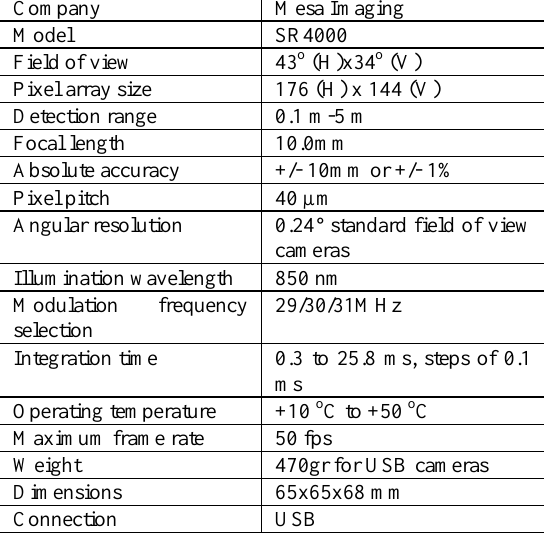
Figure 2. The measurement side